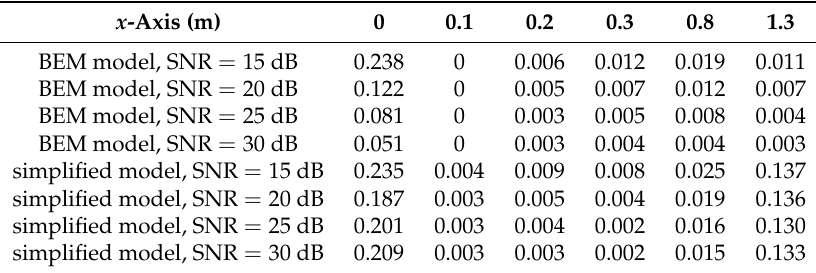
Figure 8. The RMS errors of the position estimated by using the simplified model and the BEM model, when the target is set at different positions. Table 2. The RMS errors of the position estimated versus different